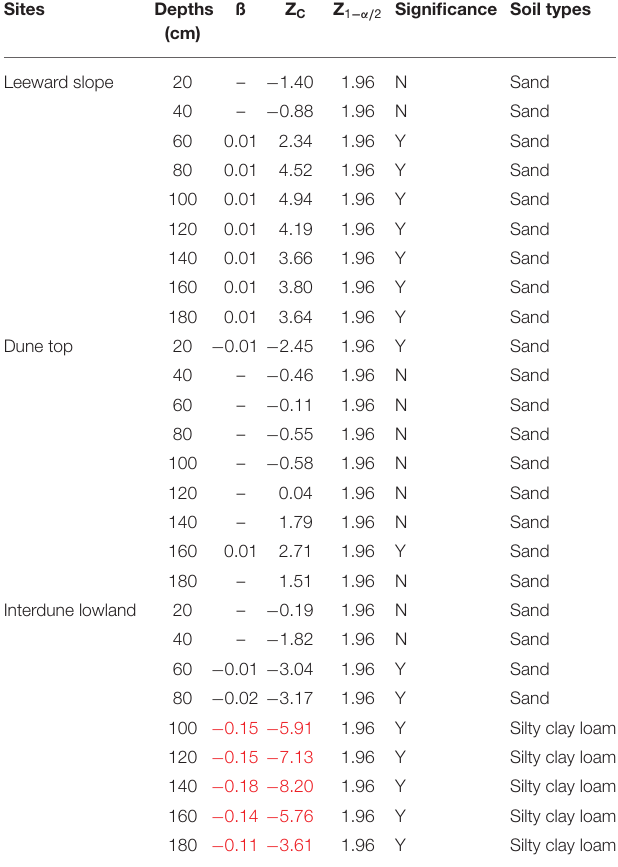
TABLE 1 | Mann–Kendall test and field trends of soil water content in desert (red represents sharp decrease rate of soil water content). Sites Depths